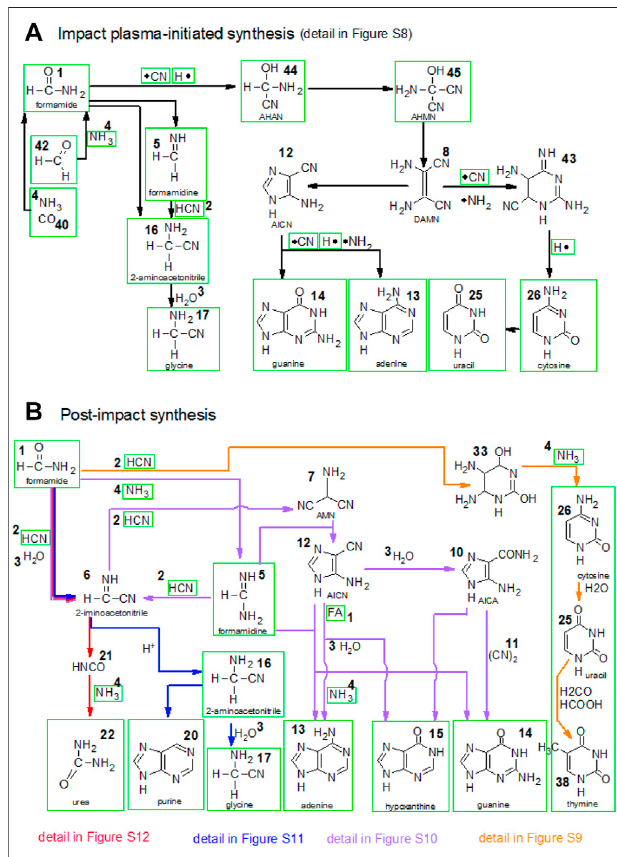
FIGURE 5 | Panel (A) Reaction scheme of radical chemistry responsible for the synthesis of nucleobases initiated directly by an impact plasma. Panel (B) Scheme for post-impact synthesis in impact craters starting with hot formamide. Both: Intermediates and products that are detected in the current and in previous studies are shown in green frames. Details including the description of each reaction pathway are given in the Supplementary Information fi guresasindicatedbycolourshere.The fi gurewascompiledfrom data published Ferus et al. (2014); Saladino et al. (2007); Ferus et al. (2015a); Ferus et al., 2019; Pastorek et al. (2019); Slavova and Enchev (2020); Yadav et al. (2020), and Hudson et al. (2012) and references